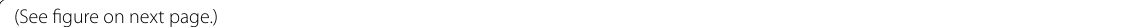
figure on next Fig. 2 Data from the incoming sites. a Depth distributions of porosity, thermal conductivity, temperature, NGR, clay mineral fraction, and lithologic units at site C0011. Green symbols in the porosity, thermal conductivity, and clay mineral fraction plots represent data from core sample measurements. Red symbols in the porosity, thermal conductivity, and temperature plots indicate data estimated using the electrical resistivity logs. Black symbols in the NGR plot are the original (not normalized) NGR values, and green and red symbols are the NGR normalized using the MAD porosities and porosities estimated from the electrical resistivity logs, respectively. Red symbols in the clay mineral fraction plot are results estimated using the new method developed in this study. In the rightmost panel, USB, MSB, and LSB represent the upper, middle, and lower Shikoku Basin sediments, respectively. Lithological units colored by red represent the standard sediments, for which the empirical conversion function is established. Lithological units colored by green represent the upper part of USB sediments or the slope apron facies younger than 1.5 Ma, which shows higher normalized NGR log values than the standard sediments possibly due to volcanic ashes included in sediments. b Same as a , but for site C0012. Lithological units colored by gray are excluded from comparison in Fig. 7 due to poor data condition. c A seismic profile around incoming sites after Figure F2 of Expedition 333 Scientist